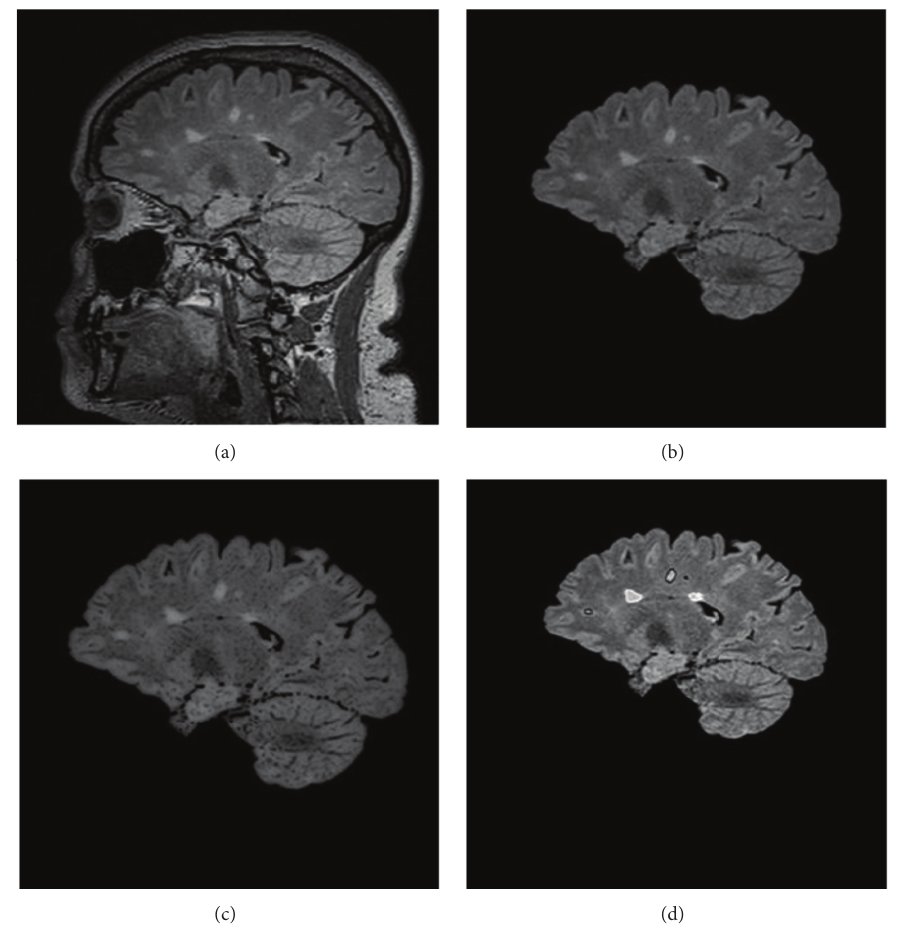
Figure 3: A 3D sagittal view FLAIR brain image. (a) Original images; (b) after skull stripping and bias field correction; (c) after high pass suppression of GM edges; and (d) the final segmentation of lesions and assignment of their locations (black contour for DWMH, white contour for